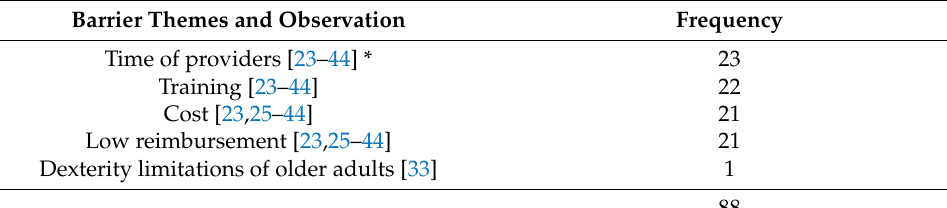
Table 6. Barriers to the adoption of mHealth and VR for memory care. Barrier Themes and